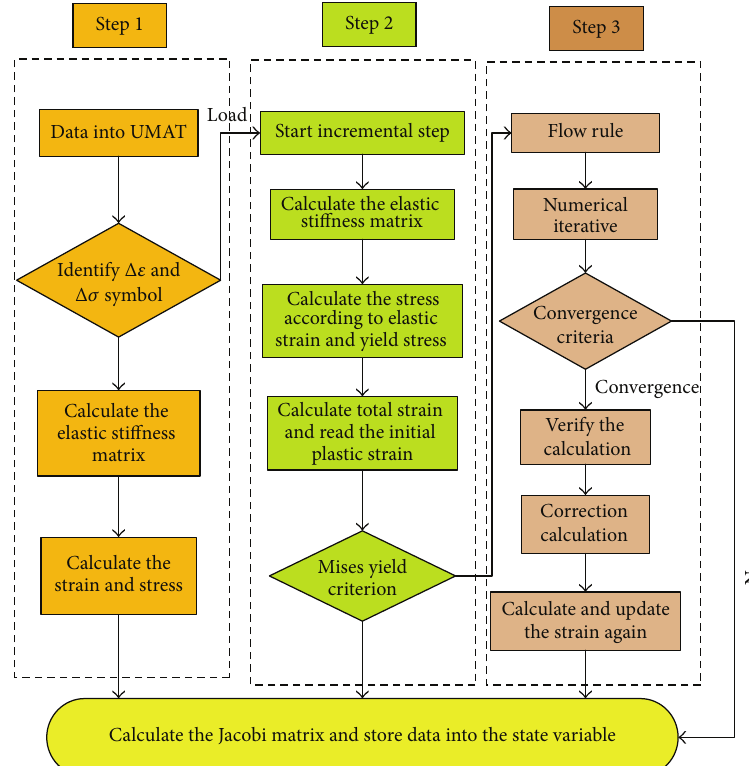
Figure 5: The flow chart for